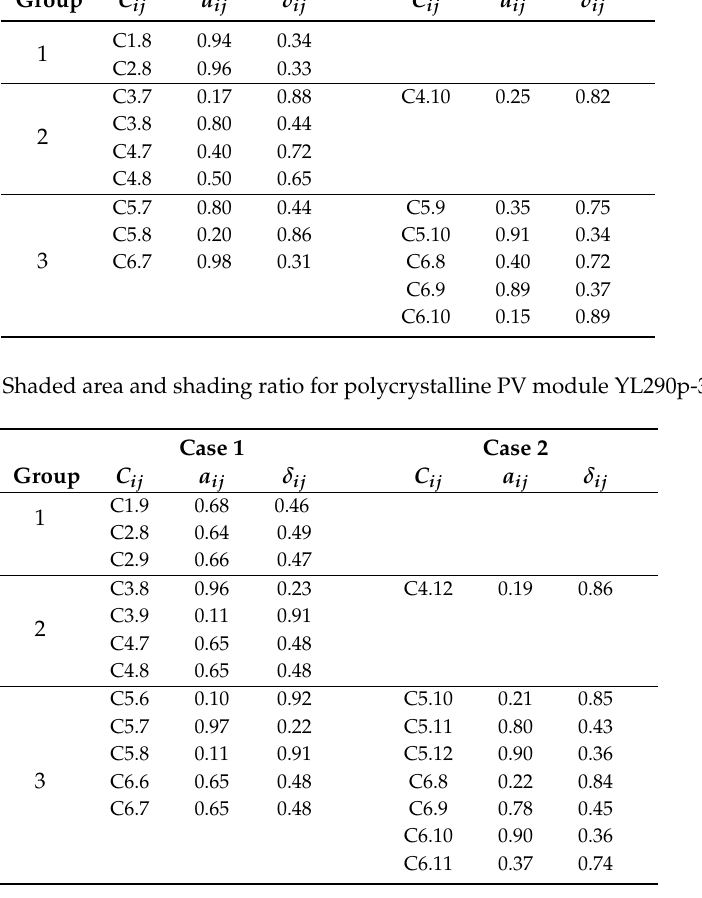
Table 8. Maximum power points—Monocrystalline.